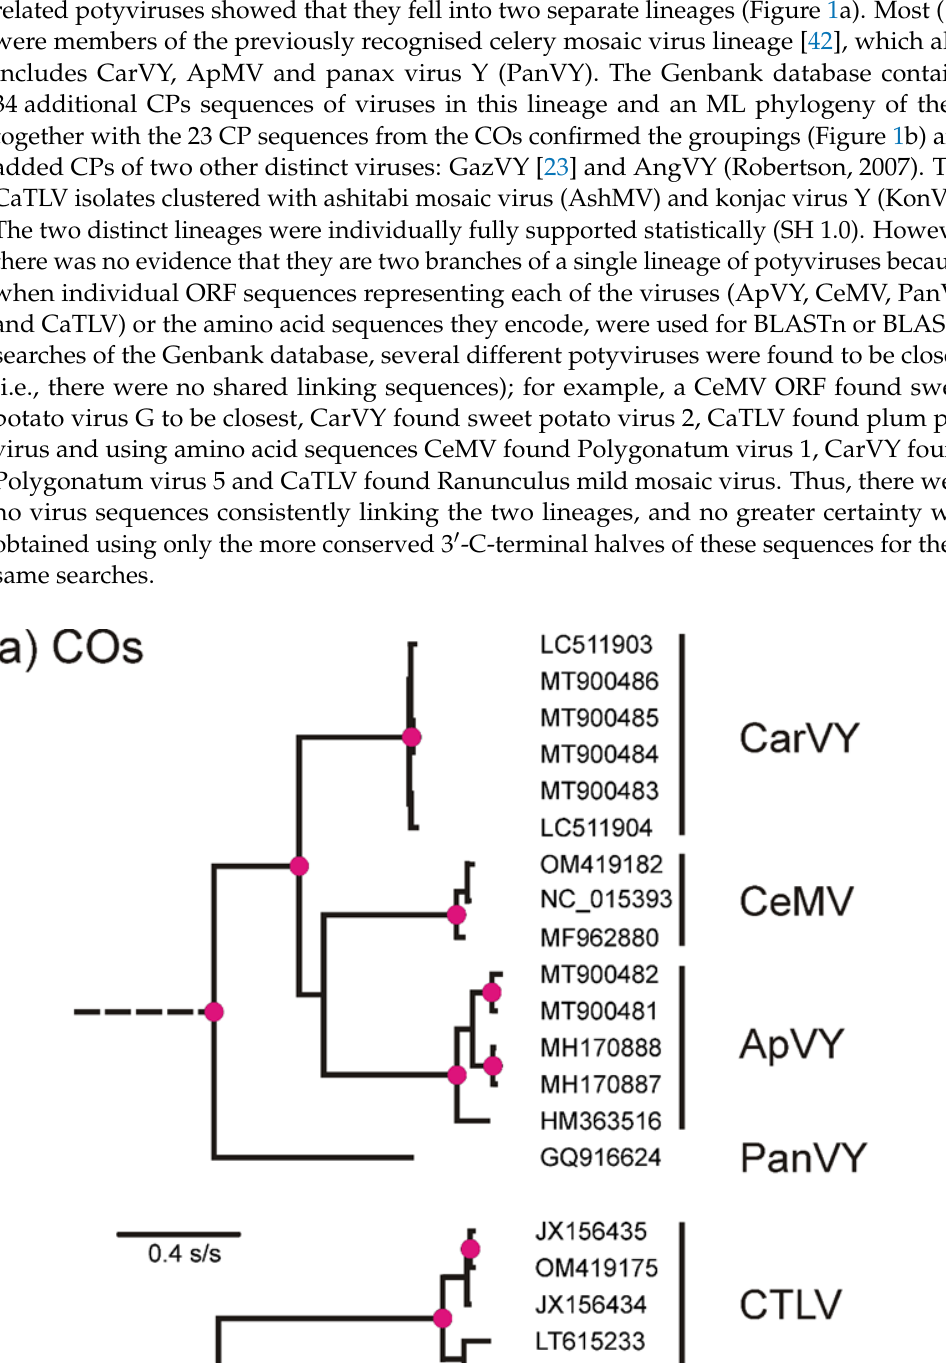
Figure 1 . ML phylogenies of: ( a ) the non-recombinant complete ORFS (COs) of the two lineages of potyviruses that were analysed; ( b ) the coat protein (CP) genes from the COs together with those downloaded from Genbank; the total number of sequences contributing to each ‘ collapsed ’ cluster in parentheses. Abbreviations: AngVY, angelica virus Y; ApVY, apium virus Y; AshMV, ashitabi mosaic virus; CarVY, carrot virus Y; CeMV, celery mosaic virus; CaTLV, carrot thin leaf virus; GazVY, gazar virus Y; KonVY, konjac virus Y; PanVY, panax virus Y. The partial ORF from sample 21625530, was of nts 928 – 1249 and 5860 – 6309 of the other sequences, and when these regions were compared, they showed the isolate to be closest to MT900482. The Gazar virus Y partial CP gene (GQ148776) was of 320 nts from the centre of the CP gene, and it was placed in the phylogeny using a phylogeny calculated using only the homologous region of all 80 other CP genes. The other CP genes are: AngVY, EF488740 and NC_043138; ApVY-Am, EU255632, EU515125, EU515126, FJ010828 and HM363516; ApVY-W, AF203529, AF207594, AY049716, FJ010827, MH170887, MH170888,